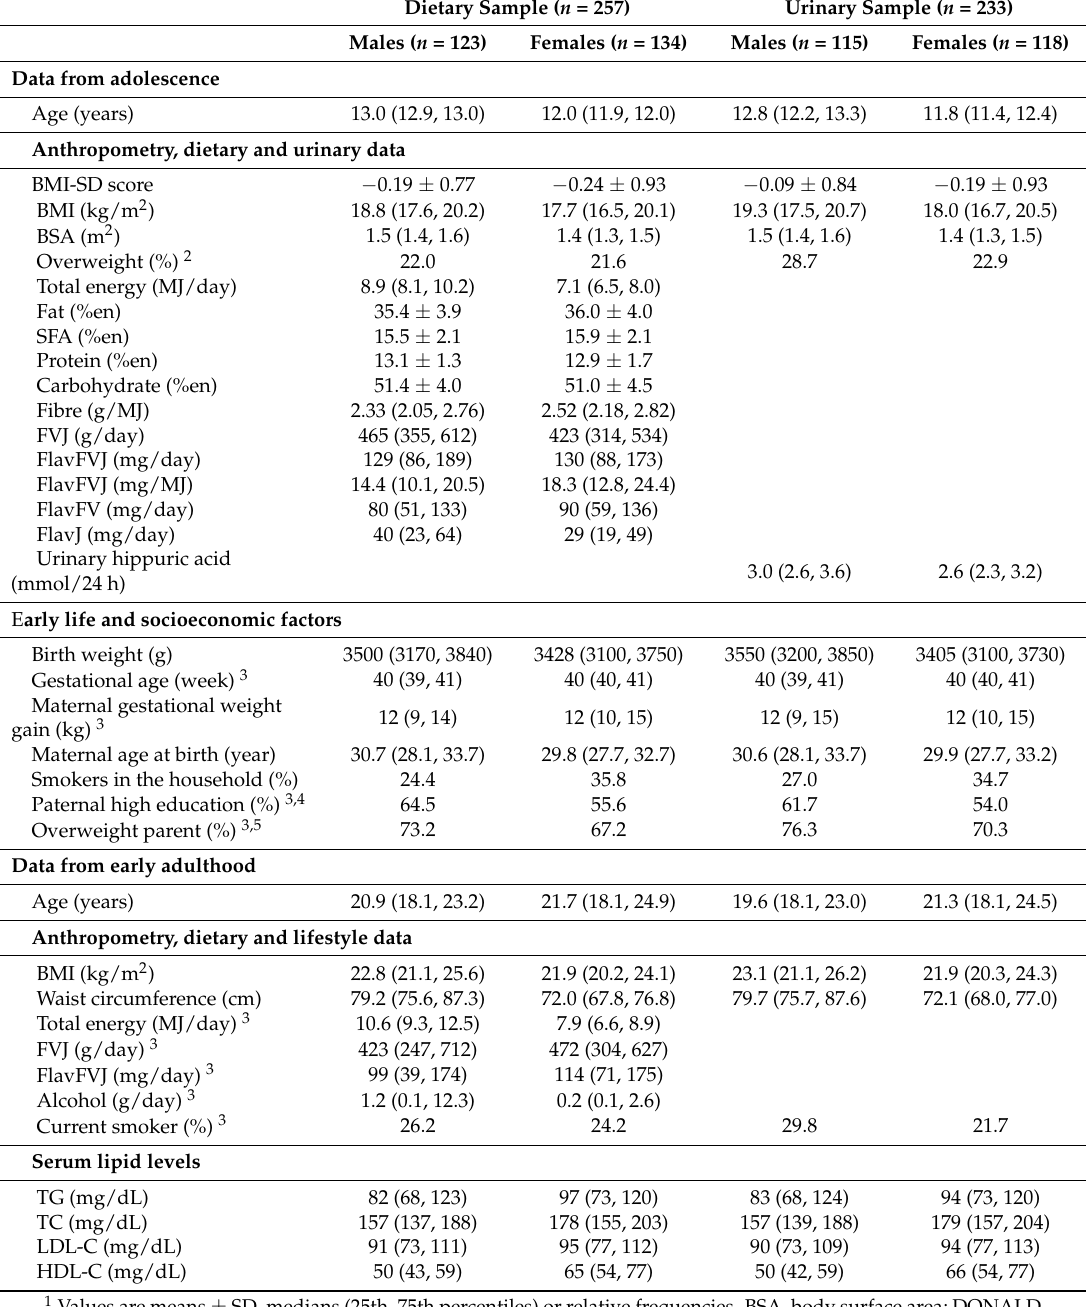
Table 1. Characteristics of the participants in adolescence (males: 10–16 years, females: 9–15 years) and early adulthood: anthropometry, dietary and urinary data, serum lipid levels, early life and socioeconomic factors 1